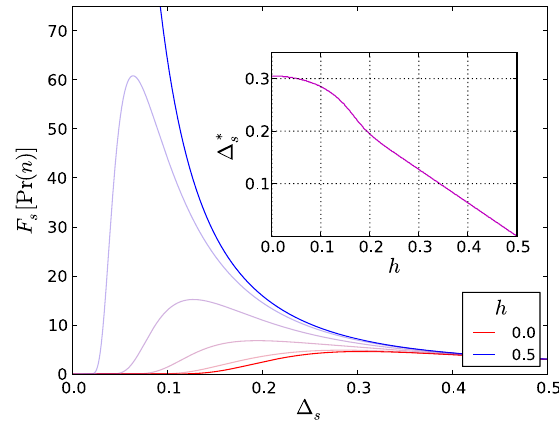
FIG. 3 Numerically obtained relationships between Fisher information and Gaussian spread Δ for fixed pixel width s 1 . The bold curves are for h ¼ 0 (lowermost) and h ¼ r s ¼ 0 . 5 (uppermost), with fainter curves interpolating linearly. With- out pixelation, narrower Gaussian distributions are superior — the delta function offers the ultimate precision. However, the mis- alignment effect introduced with pixelation combines with the low effective resolution as Δ is reduced, preventing the con- s ≳ r = 3 , alignment ceases to be tinued improvement. For Δ s s important. At any given degree of misalignment (which is Δ (cid:3) described by h ), there will be an optimum choice Δ . s ¼ s The inset shows how this optimum changes with h